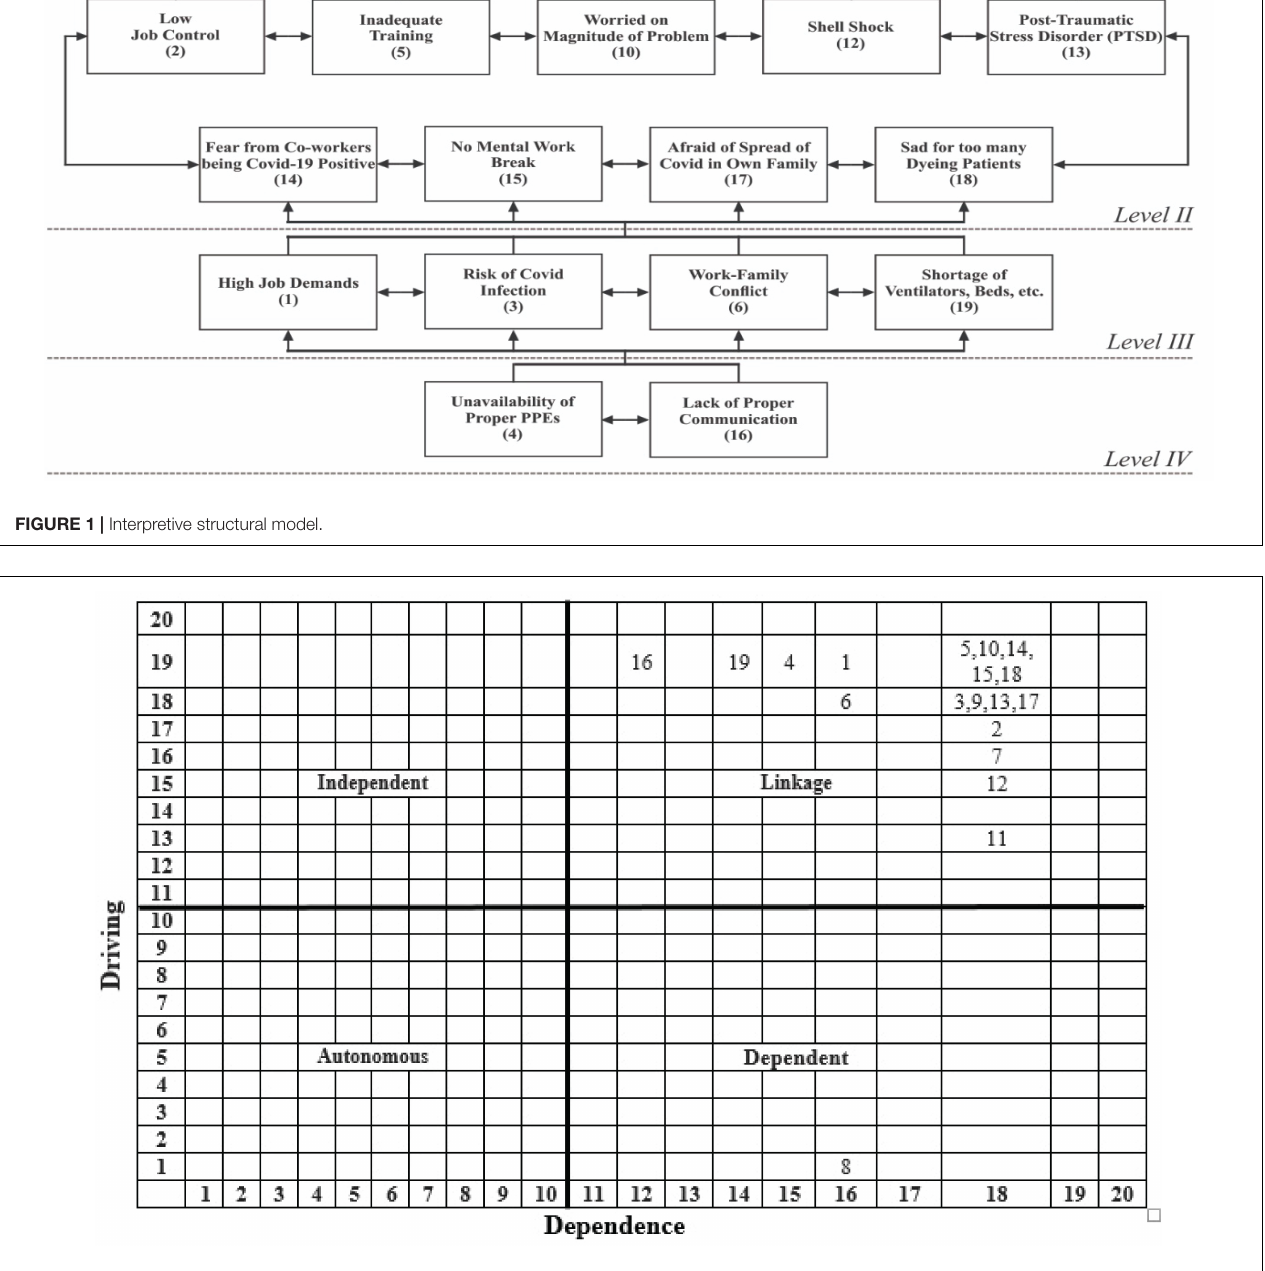
FIGURE 2 | Driving-dependence